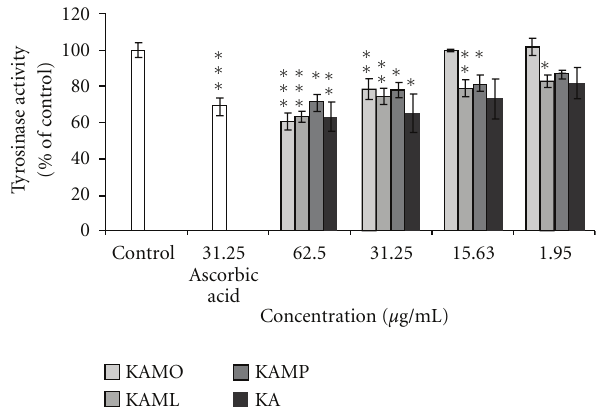
Figure 4: The results of the inhibition of tyrosinase activity by KAMO, KAML, KAMP, and KA in B16F1 melanoma cells. Denotes ∗ P < 0 . 05, ∗∗ P < 0 . 01, ∗∗∗ P < 0 . 001 compared to α -MSH treated control. Data are presented as means ± S.E.M, and expressed as % of control. 31.25 μ g/mL ascorbic acid was used as reference. n ≥ 3.